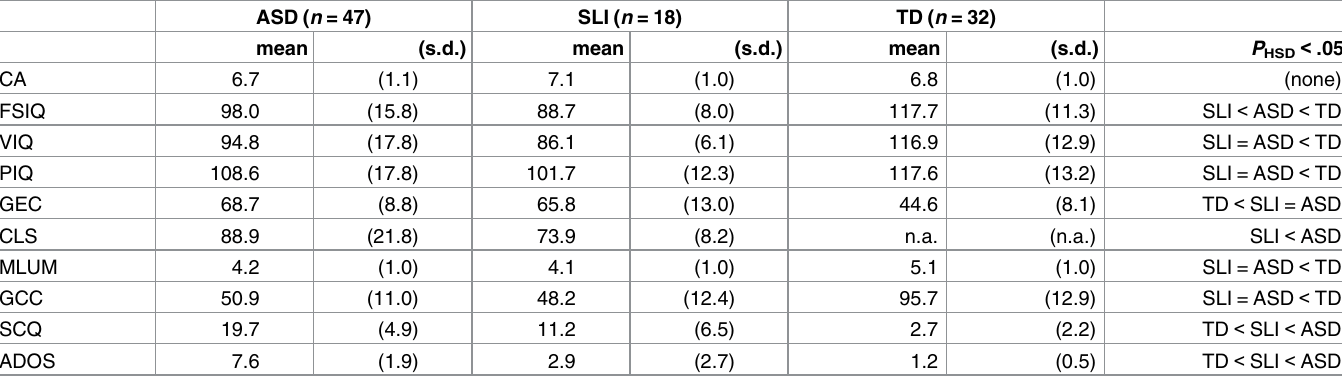
Table 2. Group summarystatistics.